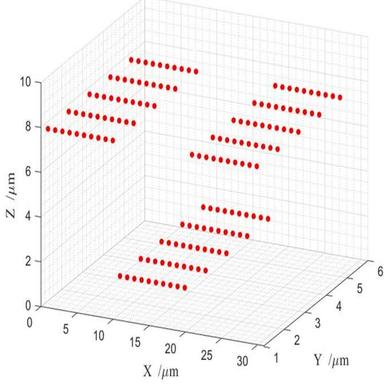
Visualization of the synthetic validation data.